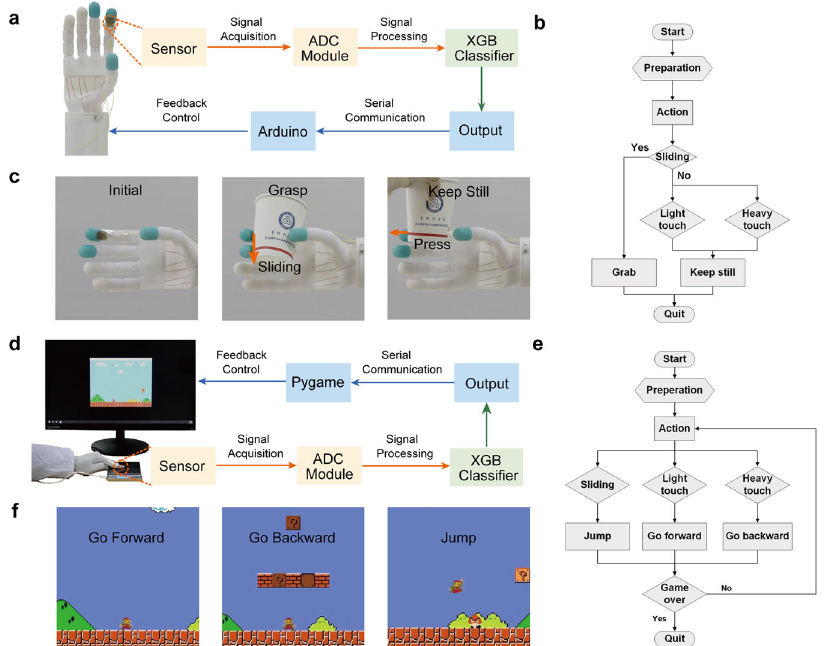
Fig. 4 Close-loop control of robotic hand and interactive Super Mario game assisted with the multifunction tactile system. a Schematic illustrations for the robotic hand assisted with the multifunction tactile system, containing analog signal acquisition, processing, machine- learning recognition, feedback control of robotic hand through Arduino. b Flow chart for the grasp operation of robotic hands. c Photographs of actual online feedback control in response to the slippage and touch of a cup. (i) initial state, (ii) grasp once the slippage occur, (iii) keep still when only measured light or heavy touch. d Schematic illustrations for the interactive Super Mario game assisted with the multifunction tactile system, showing the human fi nger equipped with the bioinspired sensor, analog signal acquisition, processing, machine-learning recognition, interactive events in Super Mario through pygame. e Flow chart for the operation of Super Mario game. f Screenshots of actual online interactive Super Mario game in response to the light touch, heavy touch and slippage by index fi nger, (i) go forward if light touch occur, (ii) go backward once heavy touch occur, (iii) jump if sliding